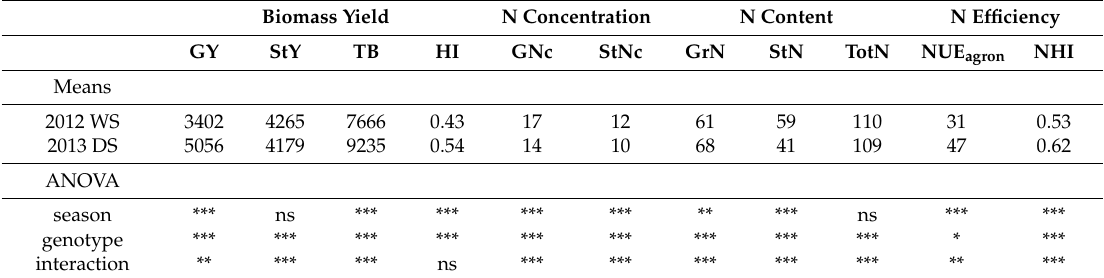
Table 1. Means of selected yield and N data parameters across 16 rice genotypes in wet season (WS) and dry season (DS) field experiments conducted between July 2012 and April